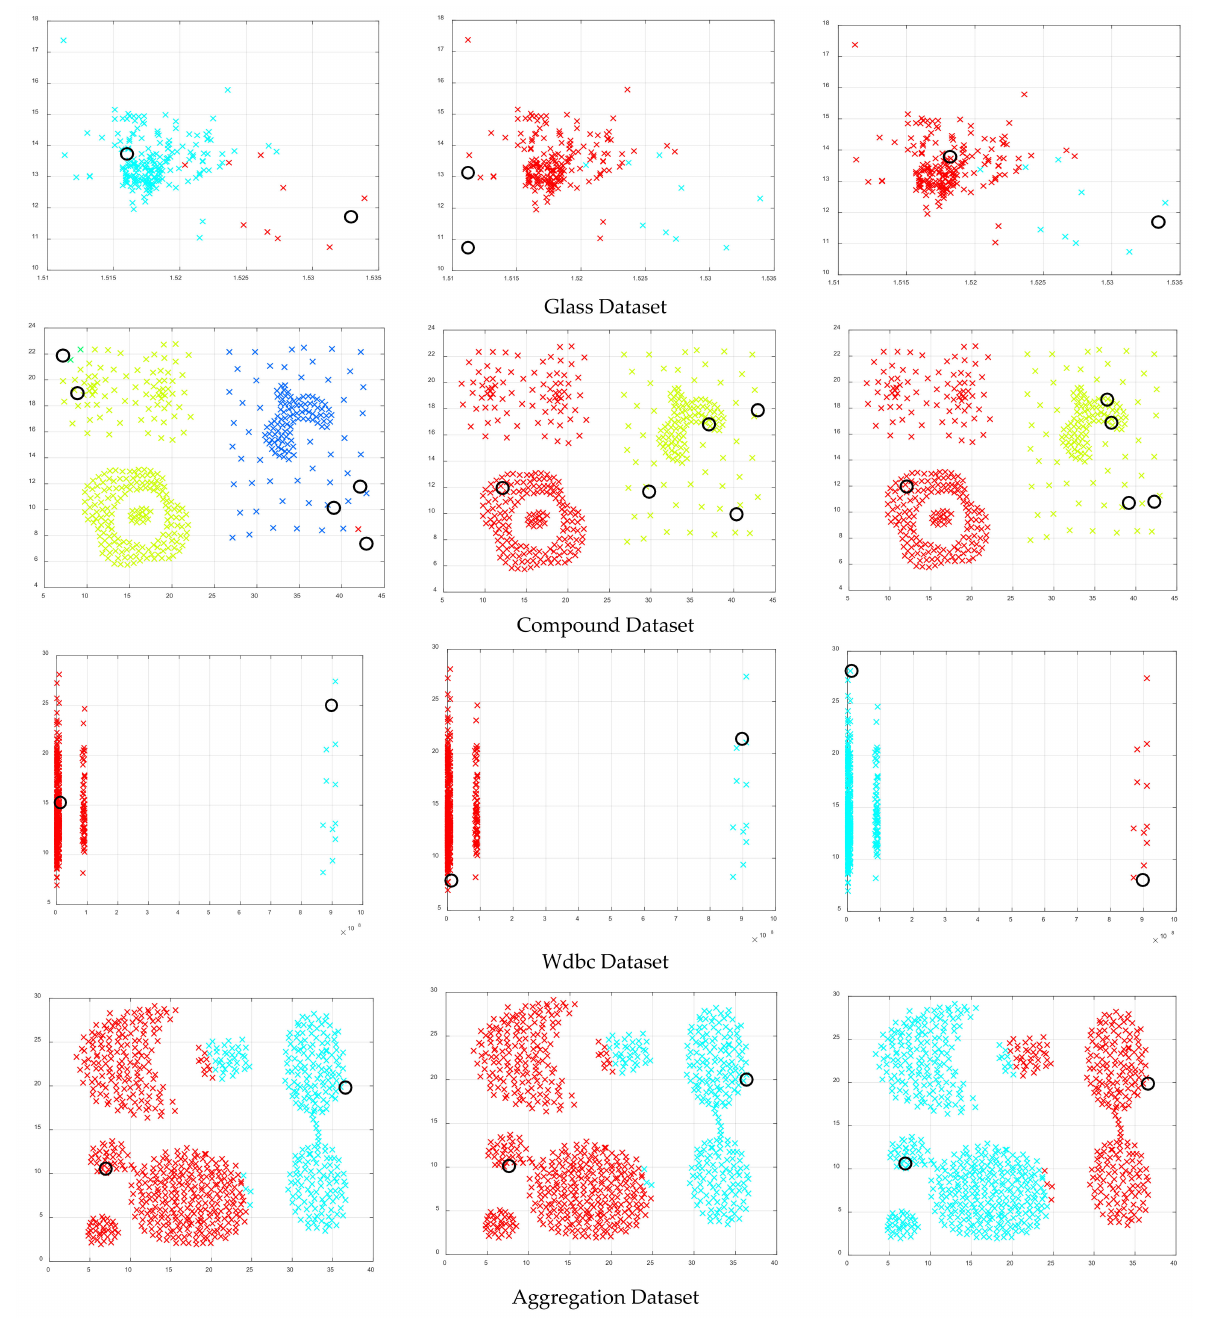
Figure 5. Clustering illustrations for HFAPSO, HCFAPSO and HVSFAPSO clustering algorithms on some selected datasets based on DB index, where the black hollow circle represents the number of clusters